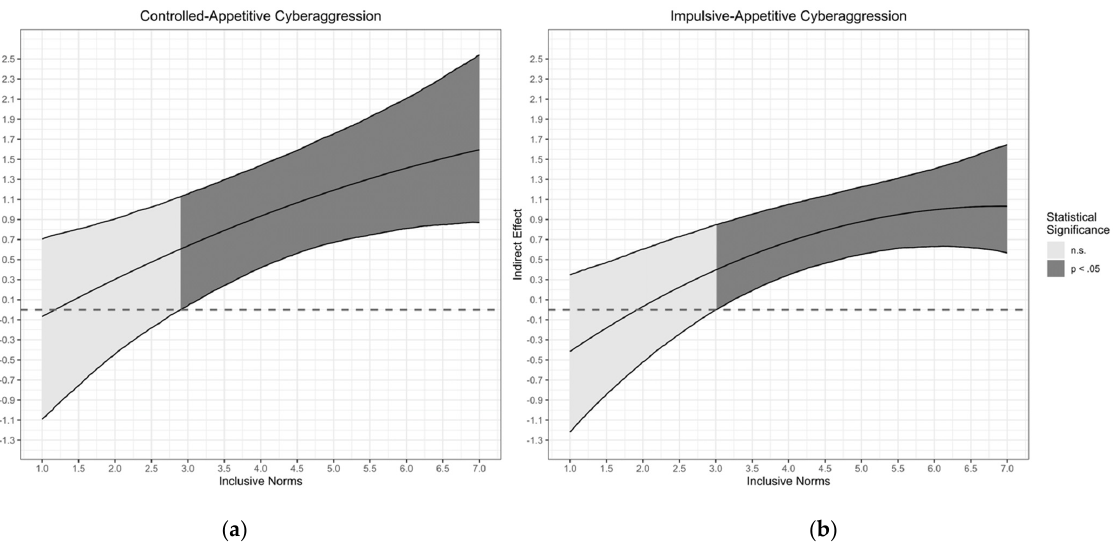
Figure 2. Johnson-Neyman Plot: indirect effect as a function of inclusive norms. ( a ) Controlled-appetitive cyberaggression; ( b ) impulsive-appetitive cyberaggression. Note. The lines represent the indirect effect conditioned on inclusive norms and lower and upper bounds of the 95% confidence bands. The dark gray areas represent the regions of statistical significance for the indirect effect at α = .05. Table 5. Results of the Moderated Mediation Analysis for Impulsive-Appetitive Cyberaggression (Impulsive-AC): Indirect and Direct Effects Moderated by Inclusive Norms